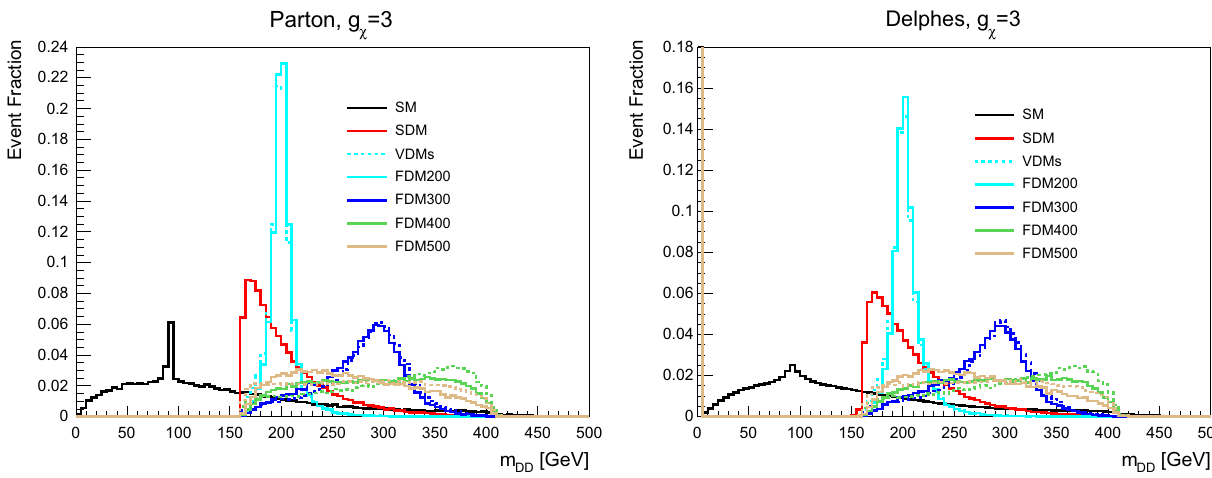
Fig. 8 Invariant mass of DM (neutrino) pair for signal (background) in the leptonic channel. The left panel shows parton level distributions. The right panel shows the detector level distributions. The meaning of the lines is the same as in Fig. 3